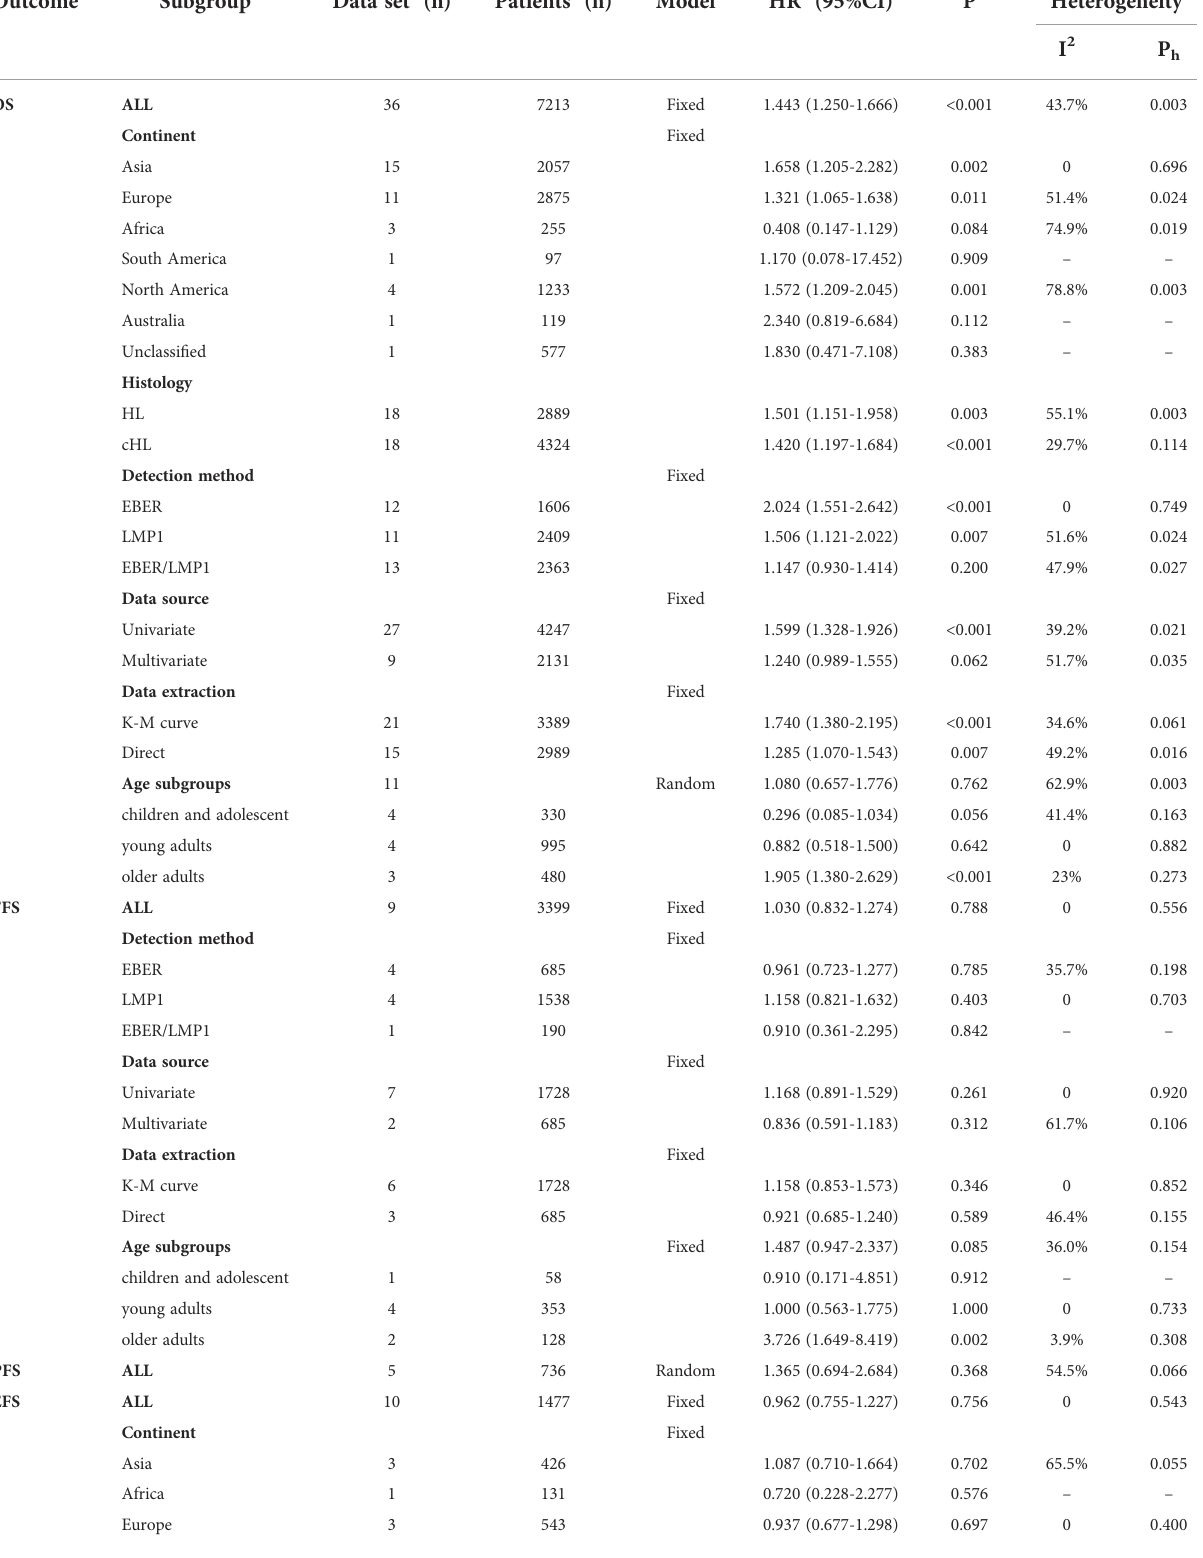
TABLE 2 Subgroup analysis of relationship between EBV infection and